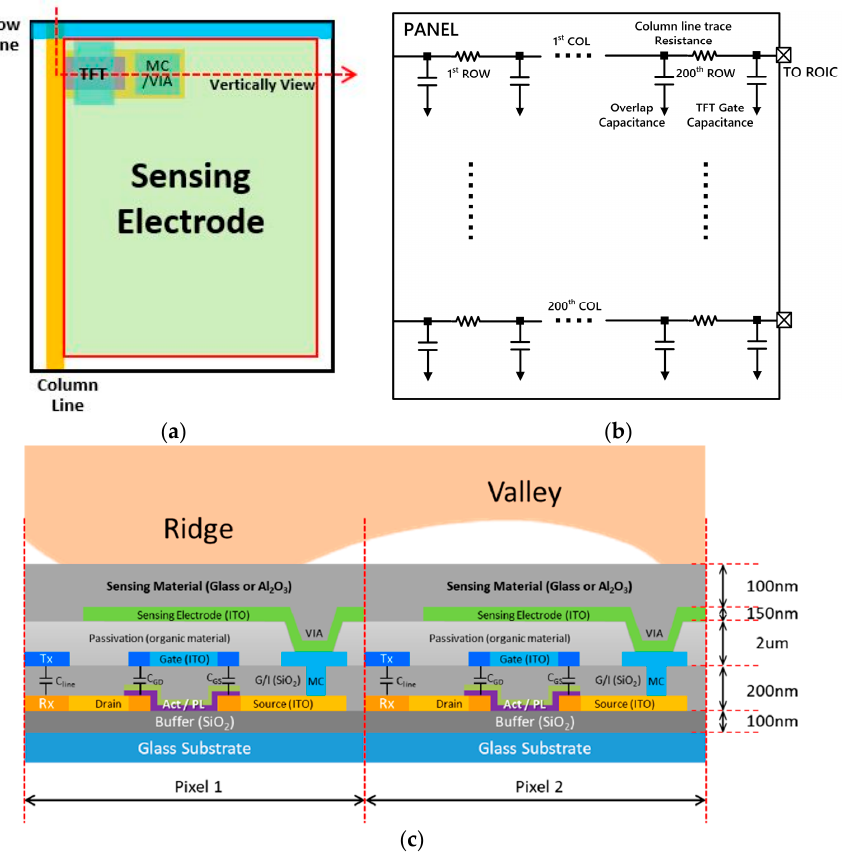
Figure 2. ( a ) Top view of the self-capacitance type sensor pixel structure; ( b ) equivalent parasitic model of the sensor array; and ( c ) cross-sectional view of the proposed sensor pixel.